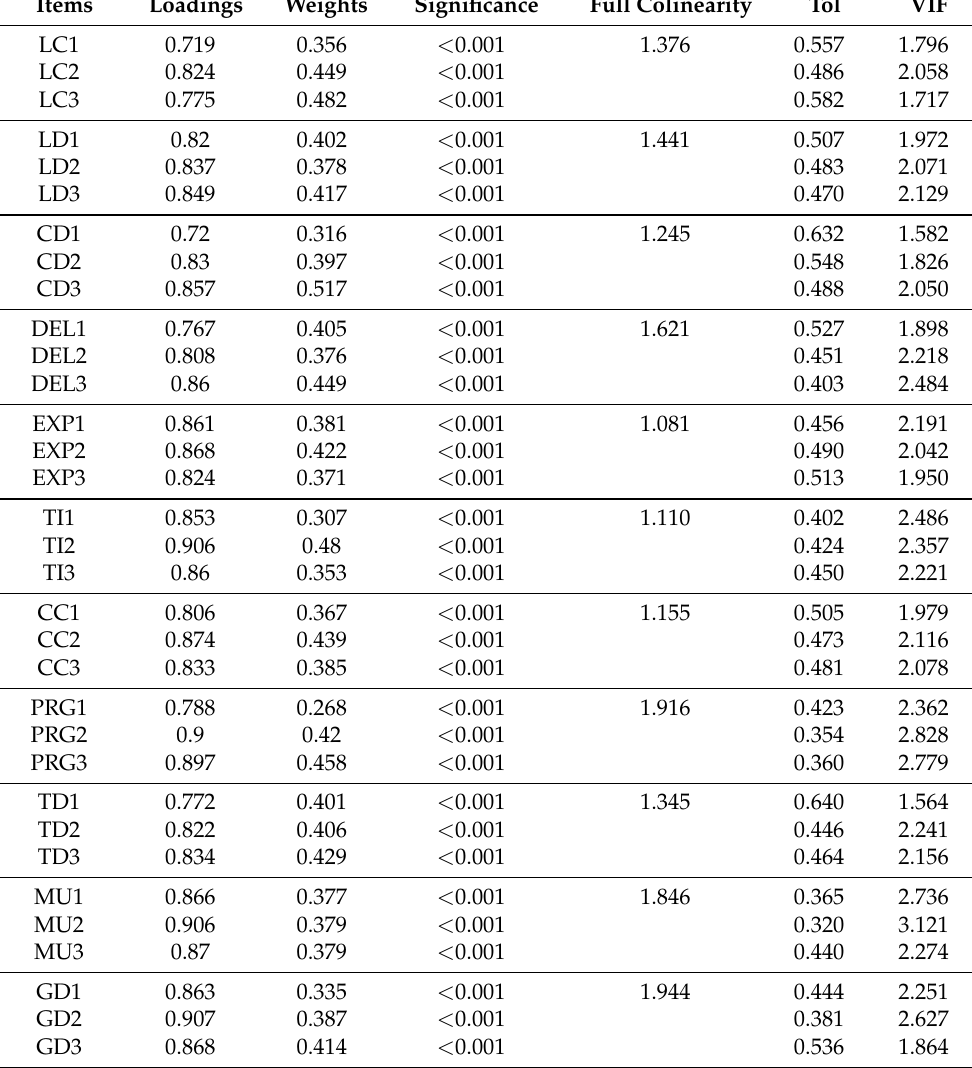
Table 7. Evaluation of formative measurement